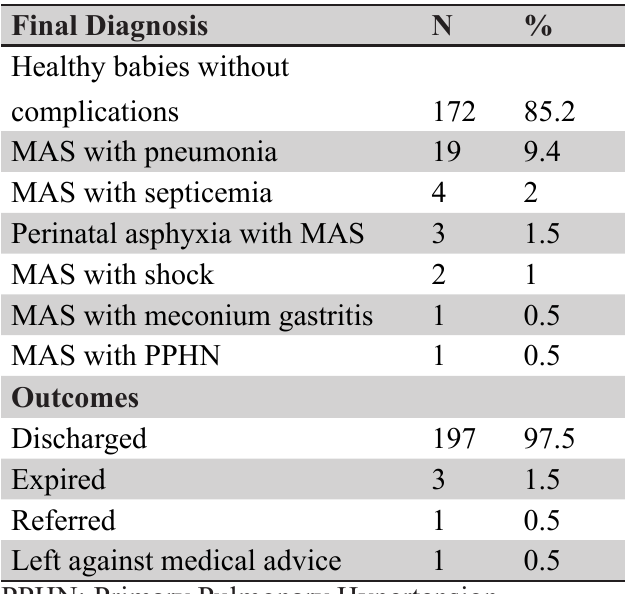
Table 5. Final diagnosis of babies born through MSAF their